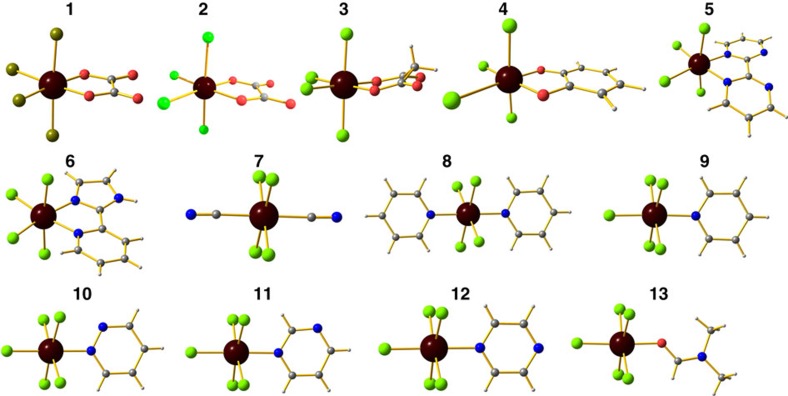
X-ray crystal structures.Crystal structure of Re(IV) mononuclear complexes. Colour code: dark brown, Re; pale brown, Br; light green, Cl; blue, N; grey, C; white, H. [ReBr4(ox)]2– (1); [ReCl4(ox)]2– (2); [ReCl4(mal)]2– (3); [ReCl4(cat)]2– (4); [ReCl4(bpym)] (5); [ReCl4(pyim)] (6); [ReCl4(CN)2]2– (7); [ReCl4(py)2] (8); [ReCl4(py)]– (9); [ReCl5(pyz)]– (10); [ReCl5(pyd)]– (11); [ReCl5(pym)]– (12); [ReCl4dmf]− (13). bpym, 2,2′-bipyrimidine; cat, catechol; dmf, dimethyl formamide; mal, malonato; ox, oxalato; pyim, 2-(2′-pyridyl)imidazole; py, pyridine; pyd, pyridazine; pym, pyrimidine; pyz, pyrazine.